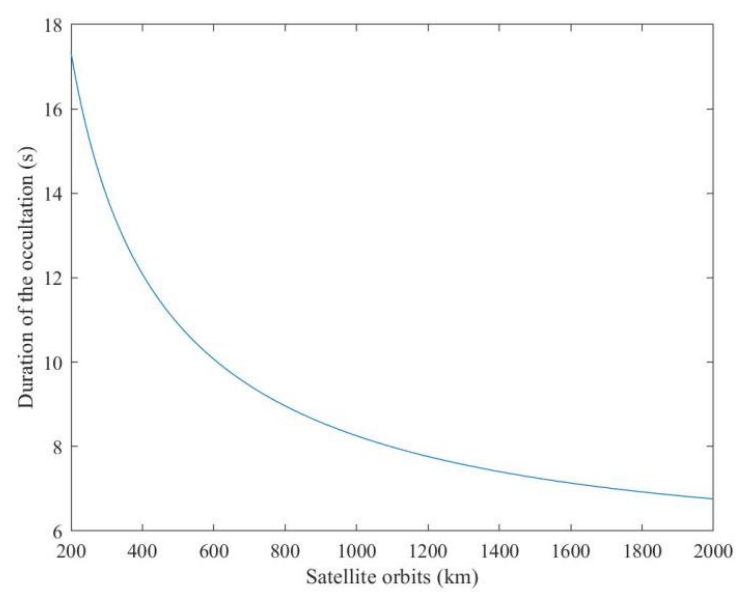
Figure 2. Duration of the occultation with the satellite orbits.